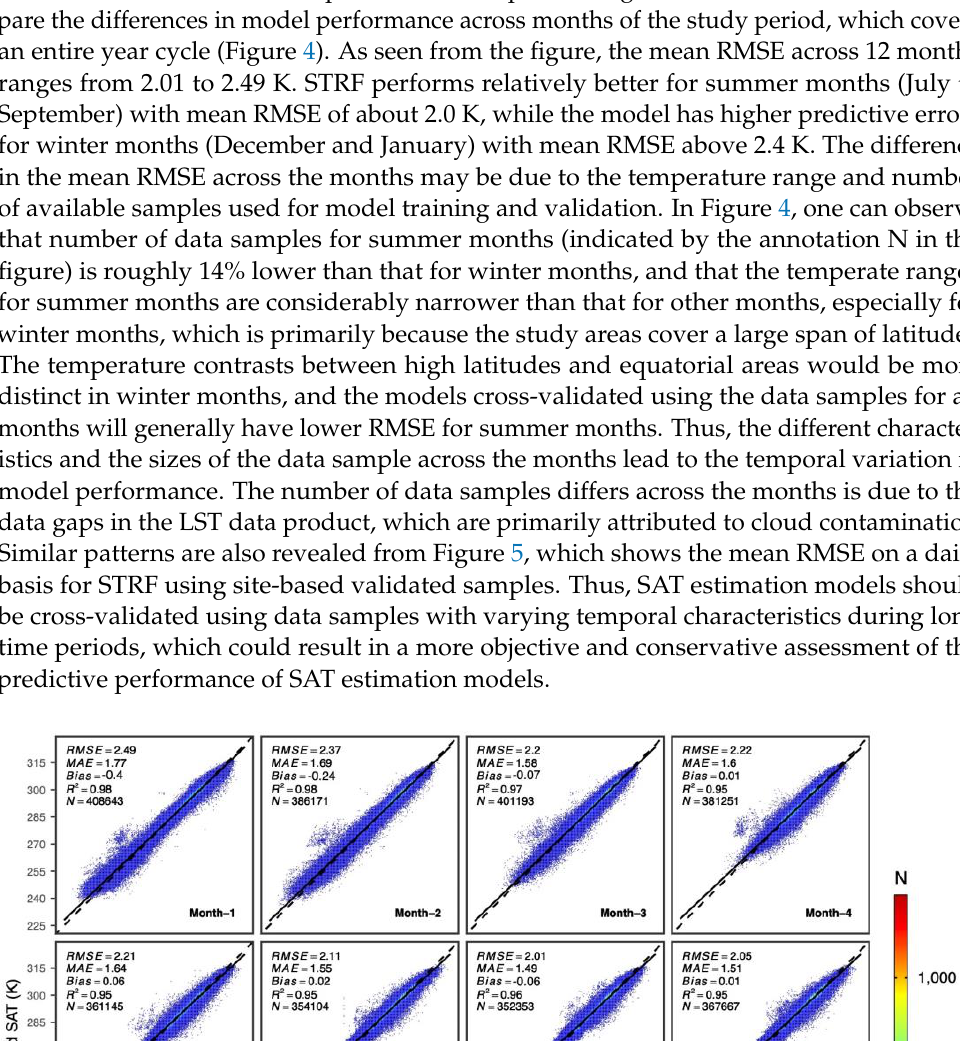
Figure 5. Daily variation in predictive performance (RMSE) of the STRF model for site-based CV. 3.3. Predictive Performance across Sites We computed the mean RMSE for each site across the study area using the cross-validated samples available at the site for the four models. Figures 6 and 7 show the